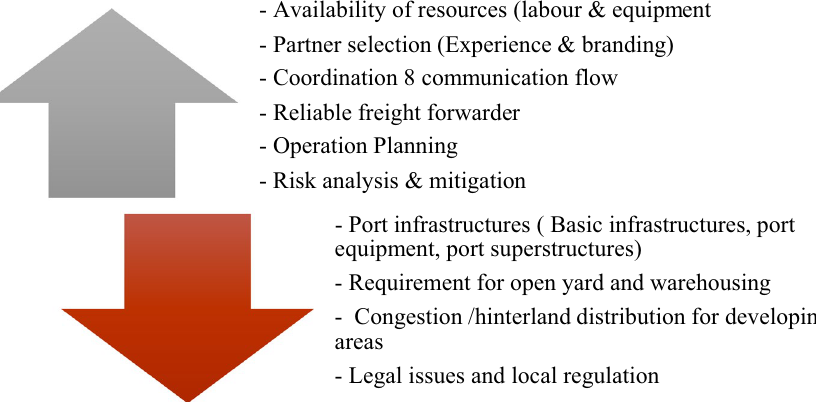
Fig. 5 Enablers and barriers of the project logistics (Denktaş Şakar et al.